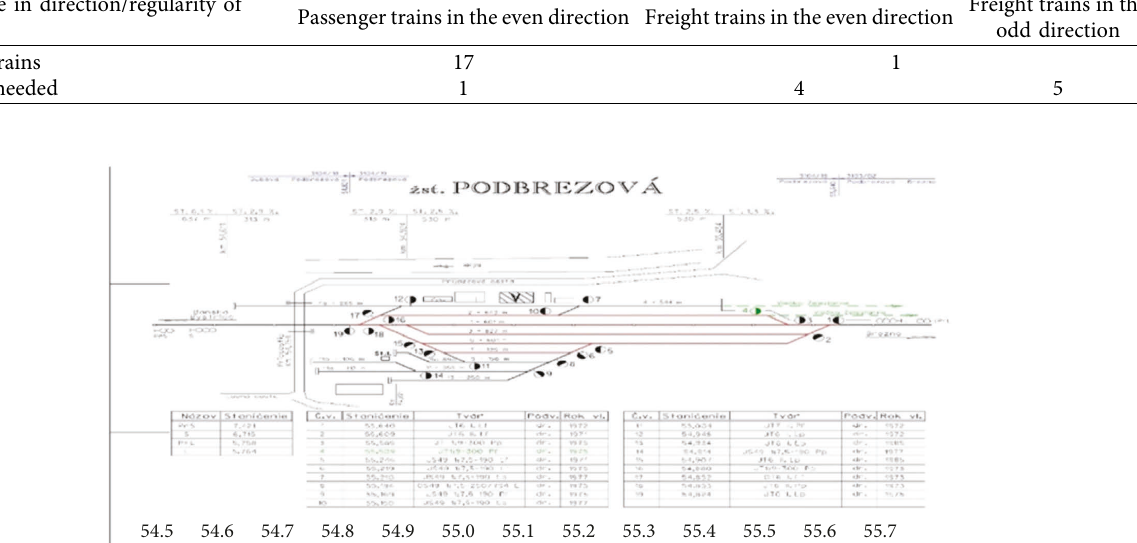
Table 2: Number of trains running through station Podbrezov´a in train traffic diagram 2021/2022. Train type in direction/regularity of